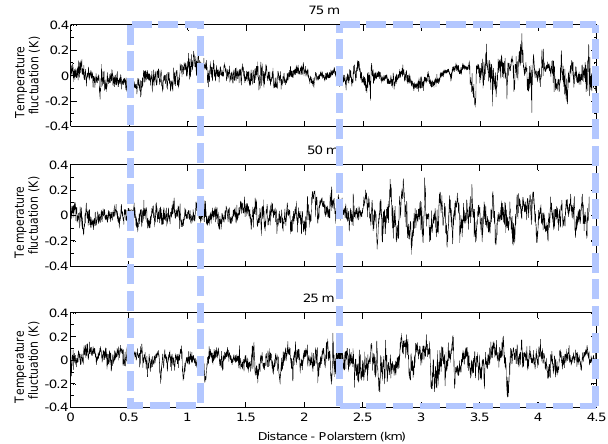
Figure 15. Time series of temperature fluctuations during the M 2 AV flights at 75, 50 and 25m altitude (from ( top ) to ( bottom )). The parts of the flight track above open water are indicated by blue